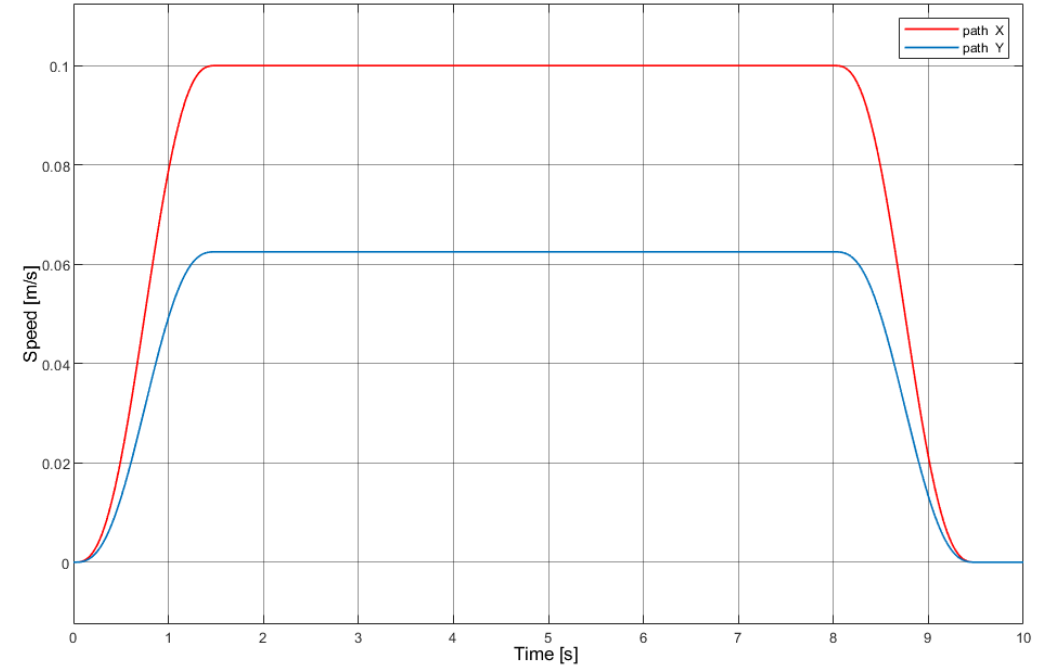
Figure 5. Trajectory for speed using 6-1-6 polynomials for the planar CDPR.